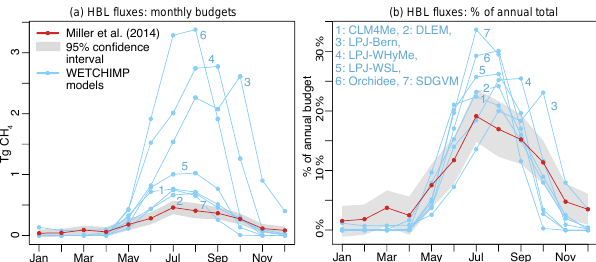
Figure 5. The seasonal cycle in methane fluxes estimated for the HBL (50–60 ◦ N, 75–96 ◦ W). We include both the WETCHIMP es- timates and an inverse modeling estimate from Miller et al. (2014). Panel (a) displays the monthly budget from each estimate while (b) displays each month as a percentage of the annual budget es- timated by a given